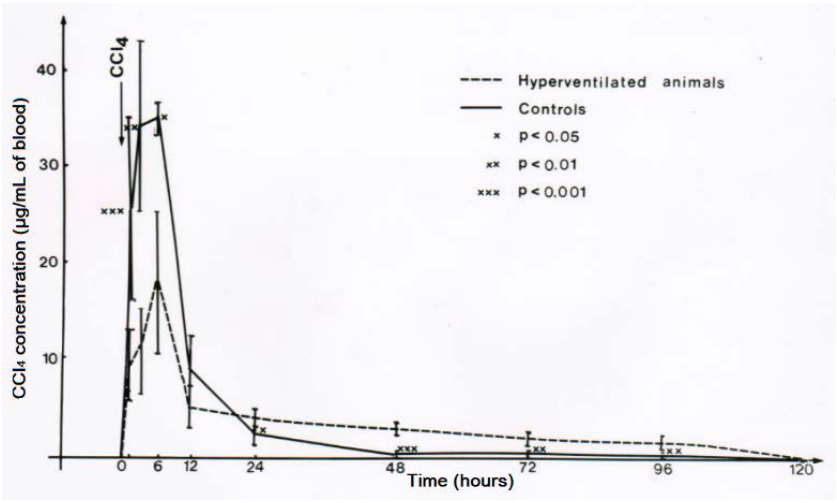
Figure 15. Experimental hyperventilation leads to a reduction of CCl 4 levels in the blood, reproduced with permission from [43]. Copyright Springer, 1983.